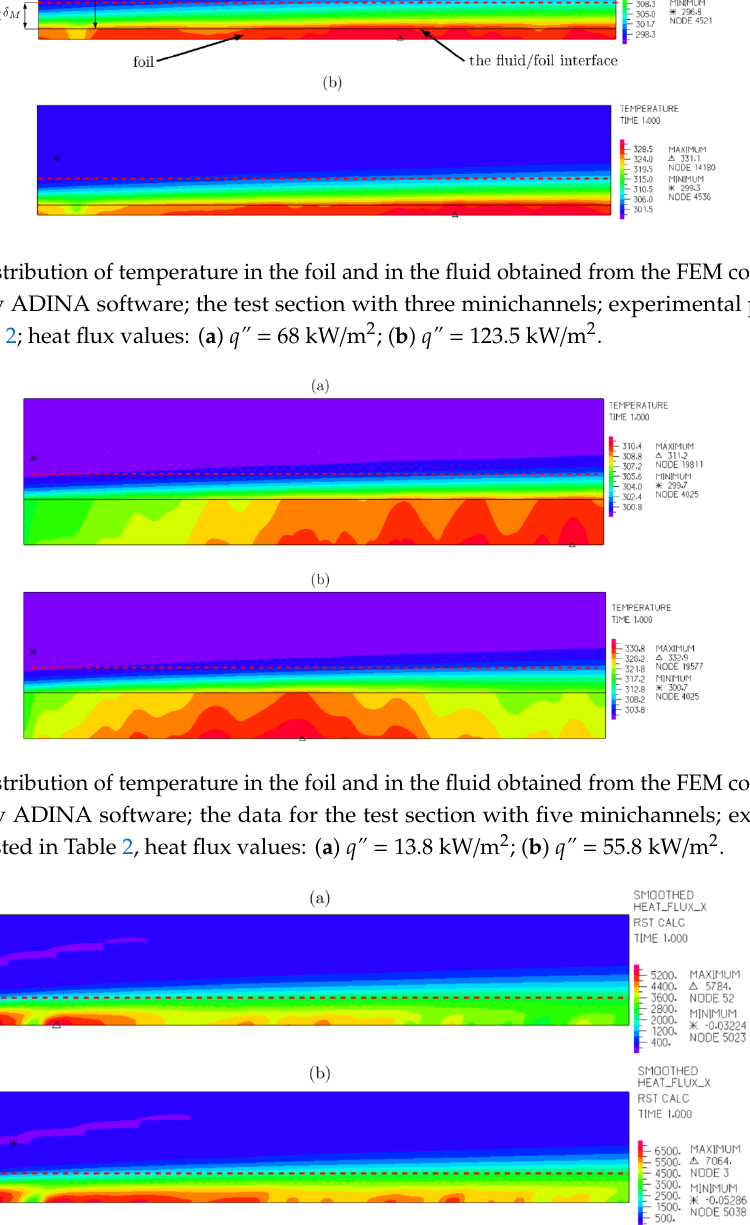
Figure 12. Distribution of heat flux in the fluid obtained from the FEM computations carried out by ADINA software; the test section with three minichannels; experimental parameters listed in Table 2; heat flux values: ( a ) q” = 68 kW / m 2 ; ( b ) q” = 123.5 kW / m 2